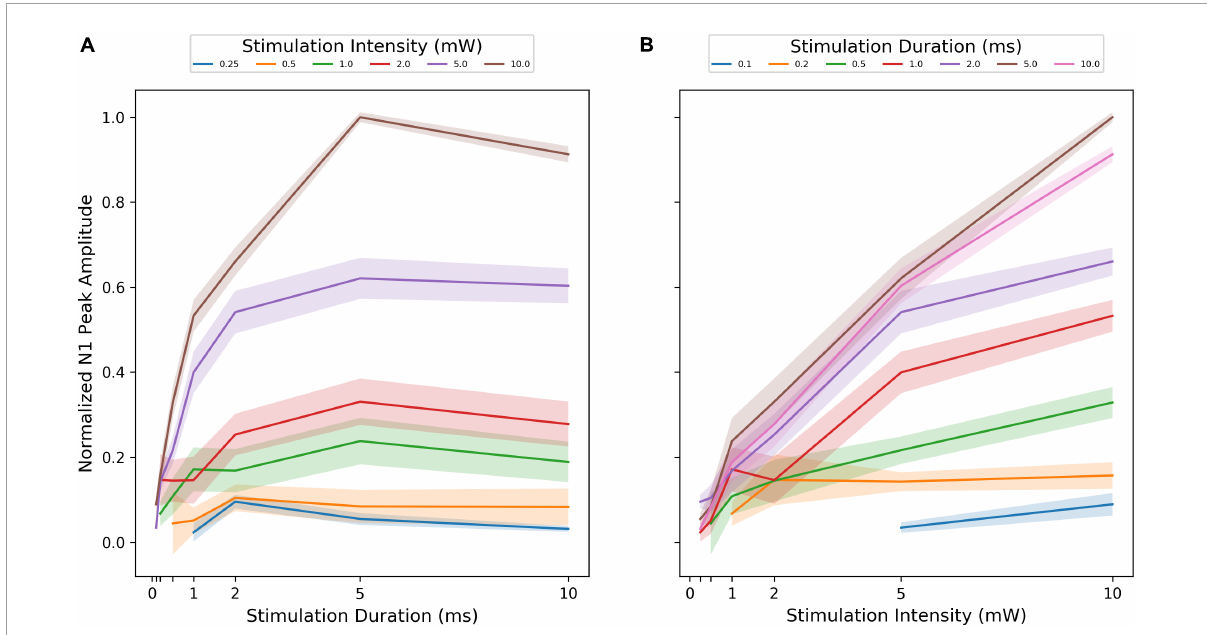
FIGURE5 Input/Output-curves for all animals ( N = 15). Y-axis reflects the N1 peak amplitude normalized by the maximum N1 amplitude of all conditions within a session for each animal. The solid line reflects the normalized group median value at a given condition, and the shadow around the line reflects the standard error of the median. (A) X-axis reflects the different stimulation durations (ms) and the different line colors reflect different stimulation intensities (mW). (B) X-axis reflects the different stimulation intensity (mW) and the different line colors reflect different stimulation durations